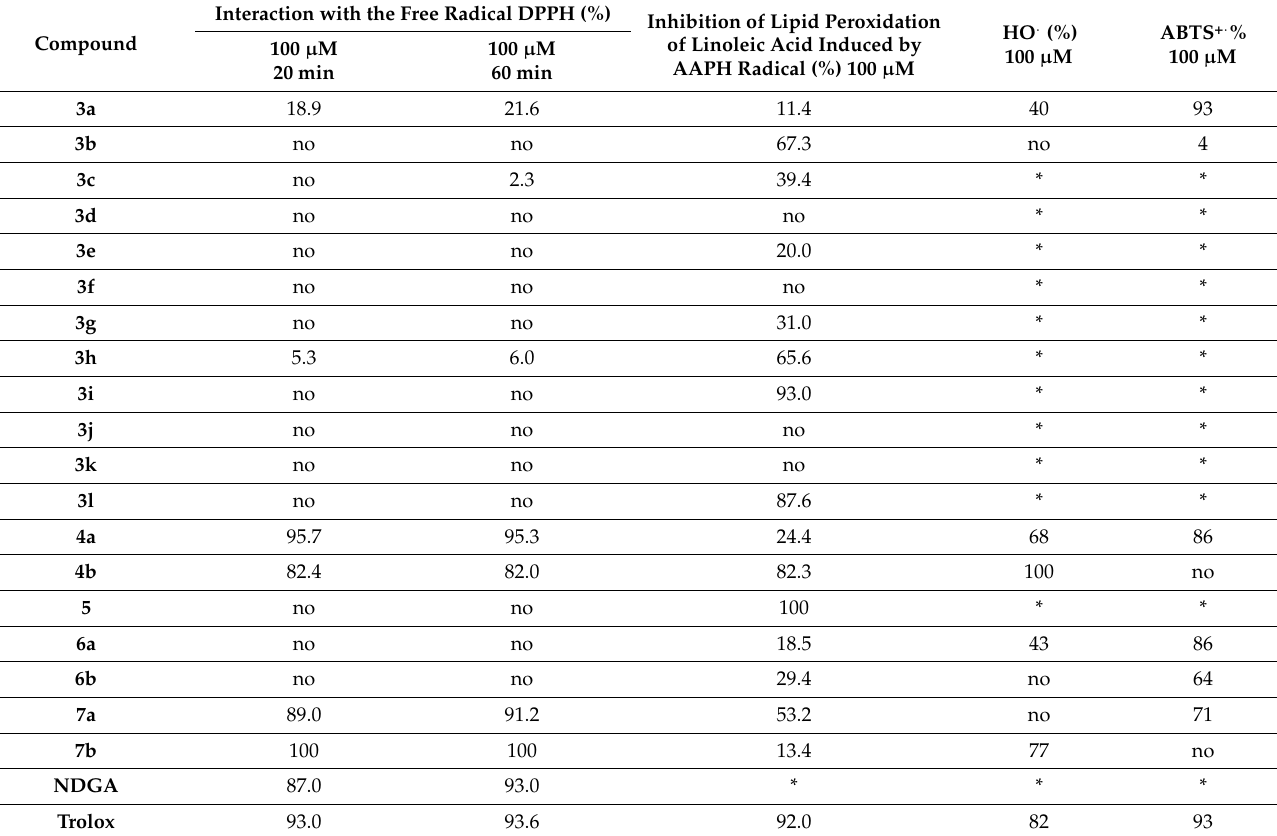
Table 2. In vitro antioxidant evaluation of the synthesized compounds, through the DPPH scavenging ability and the inhibition of linoleic acid assays, as well as antioxidant activity of selected analogues via their ability to scavenge hydroxyl radicals and the ABTS radical cation decolorization assay. Interaction with the Free Radical DPPH Compound